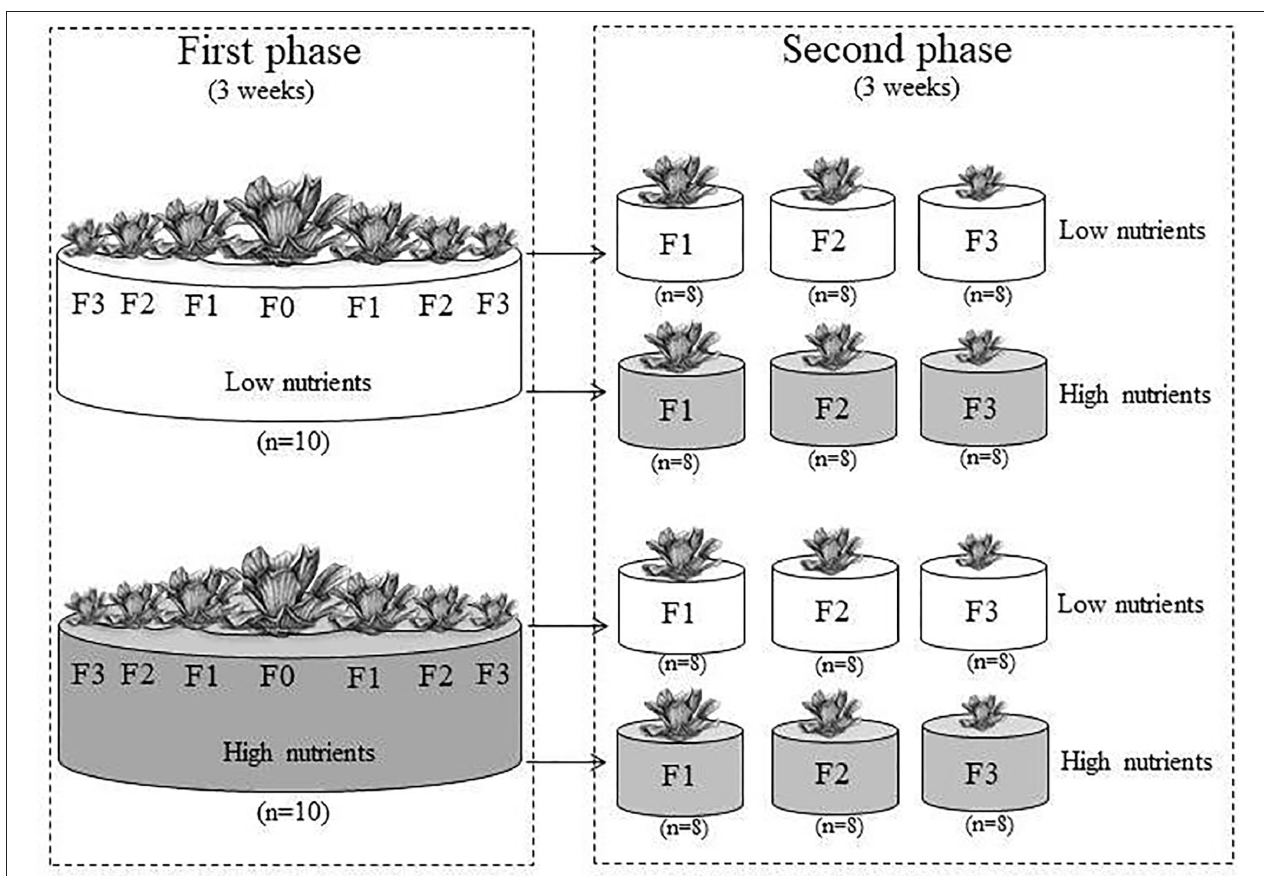
FIGURE 1 | Scheme of the experimental design. In the first phase, parent ramets (F0) produced F1, F2, and F3 offspring ramets under low or high nutrient levels. In the second phase, the F1, F2, and F3 offspring ramets from the first phase were also subjected to the same two nutrient levels.